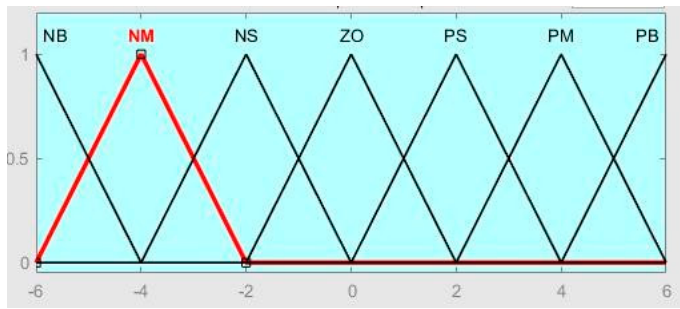
Figure 7. ∆ Kp, ∆ Ki, and ∆ Kd membership function.